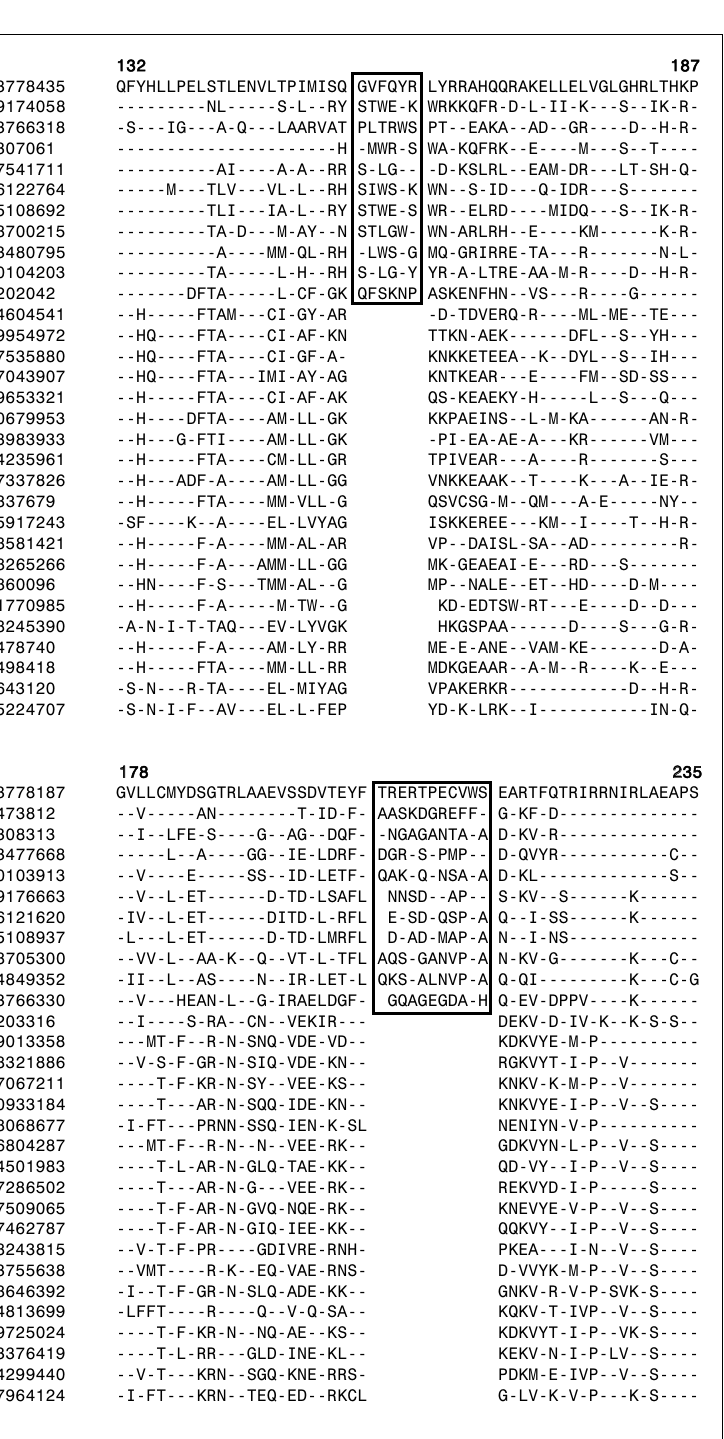
FIGURE 4 | Partial sequence alignments of (A) a conserved region within anABC transporter protein depicting a 4 aa insert that is specifically present in in all sequenced Planctomycetes species; (B)An